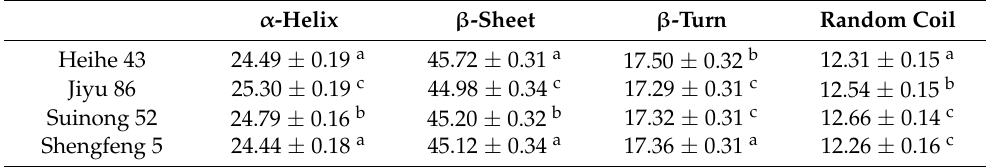
Table 3. Changes in the secondary structure of four kinds of plant-based meat analogues (PBMs) (%). α -Helix β -Sheet β -Turn Random Coil Heihe